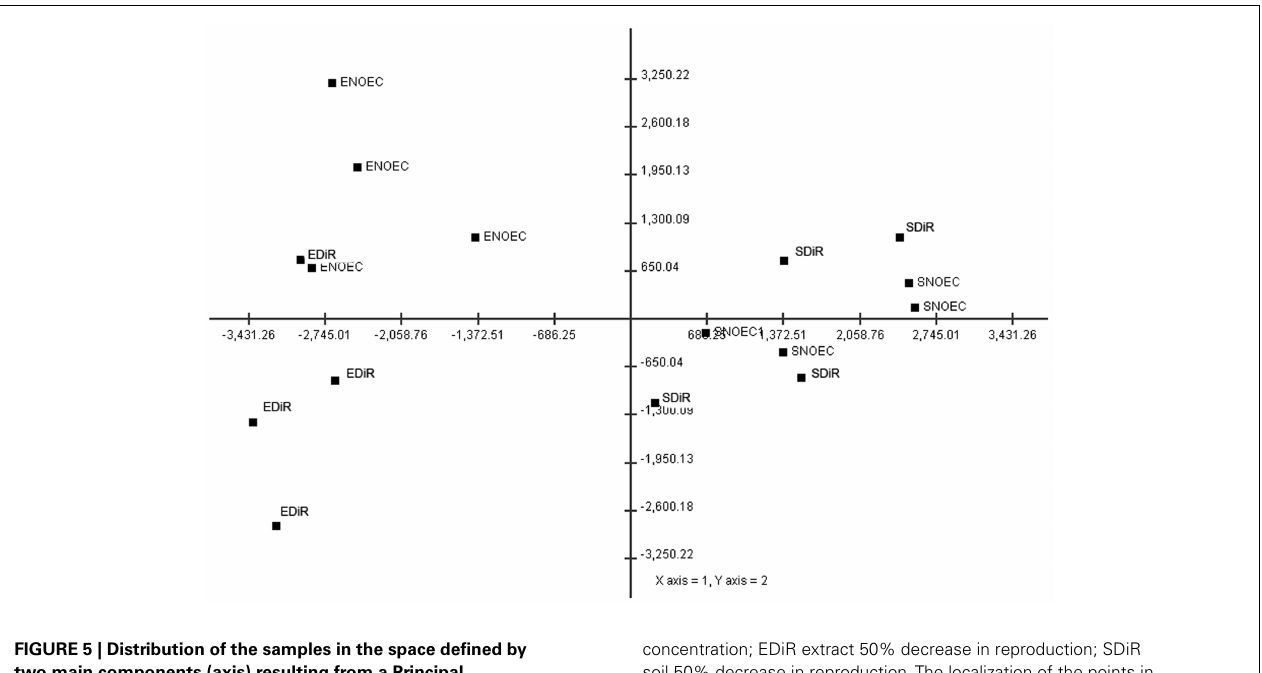
FIGURE 5 | Distribution of the samples in the space defined by two main components (axis) resulting from a Principal ComponentAnalysis. The labels indicate the sample type; ENOEC, extract no-effect concentration; SNOEC, soil no-effect